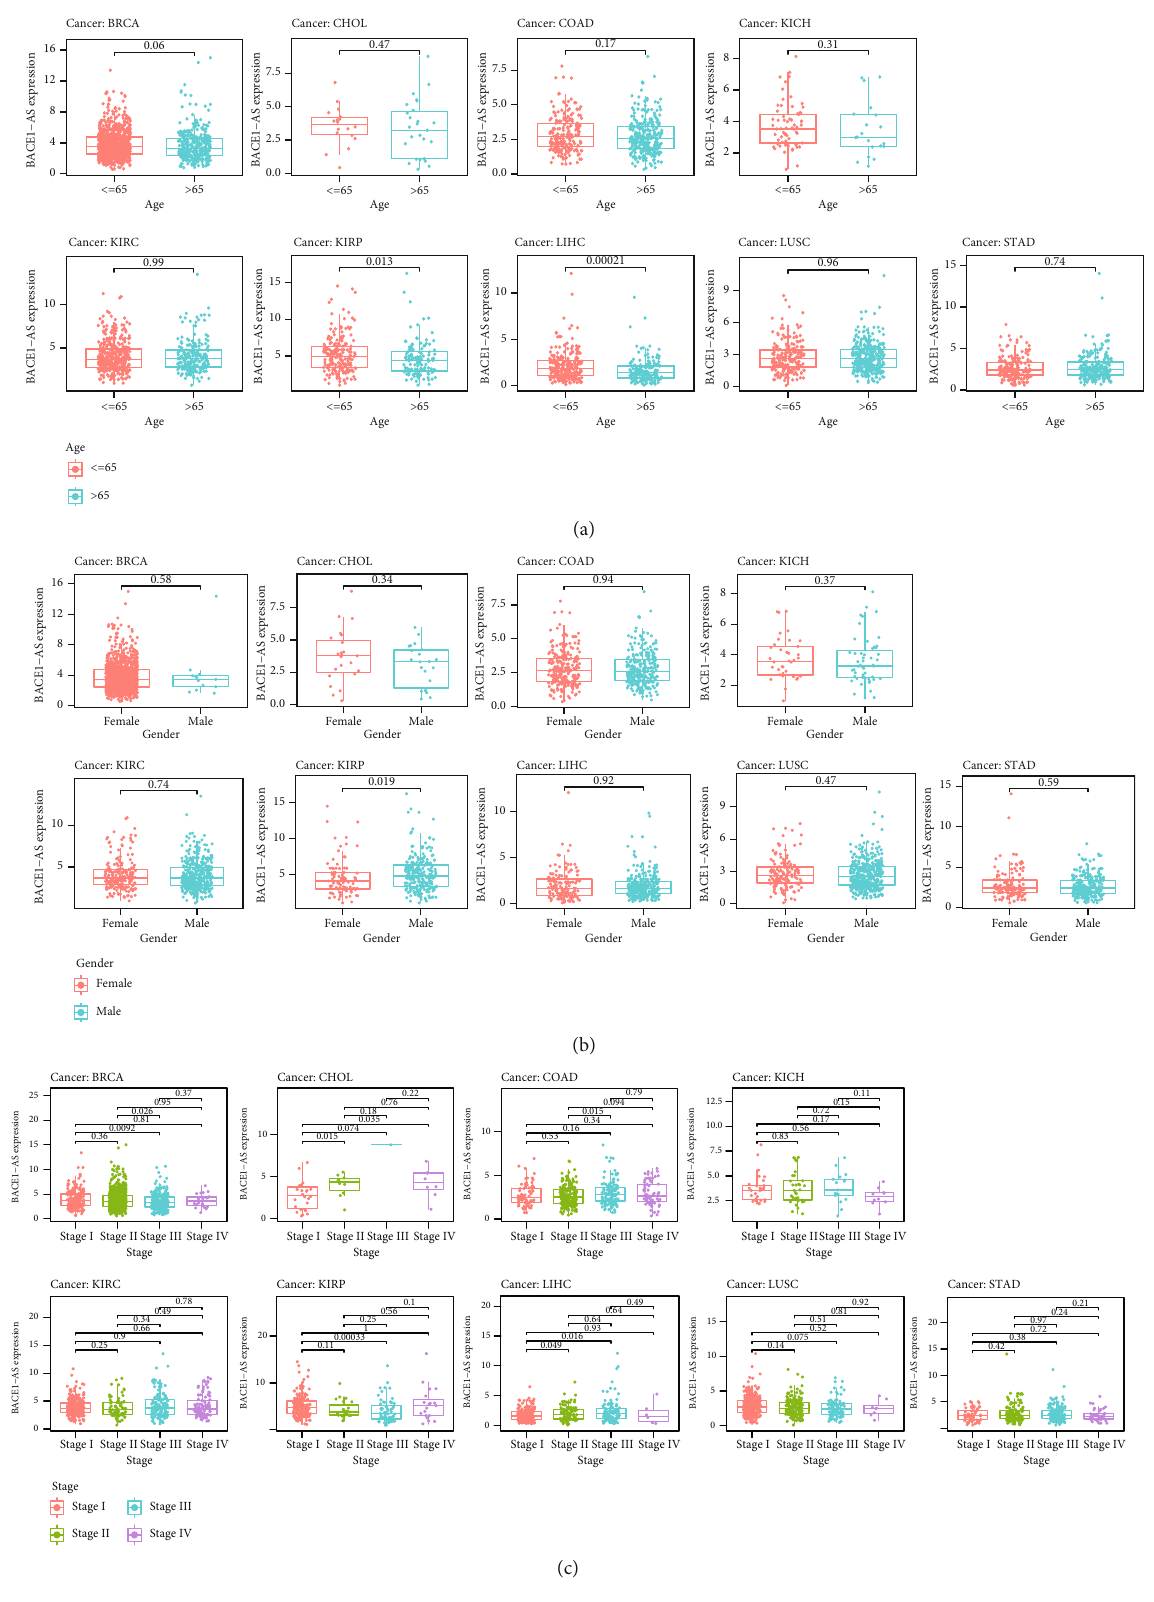
Figure 3: Correlation between the expression level of BACE1-AS and clinical characteristics. (a) Relationship between expression level of BACE1-AS and age. (b) Correlation analysis between expression level of BACE1-AS and gender. (c) The expression level of BACE1-AS in di ff erent clinical stages among di ff erent